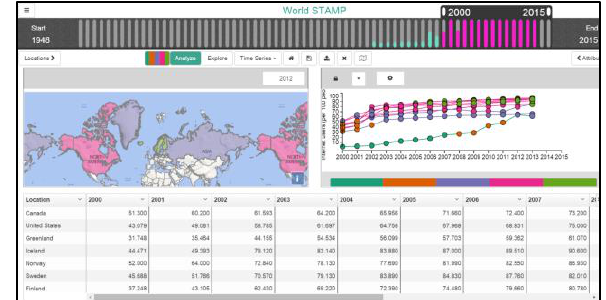
Figure 8. WSTAMP ‘Analyze’ interface